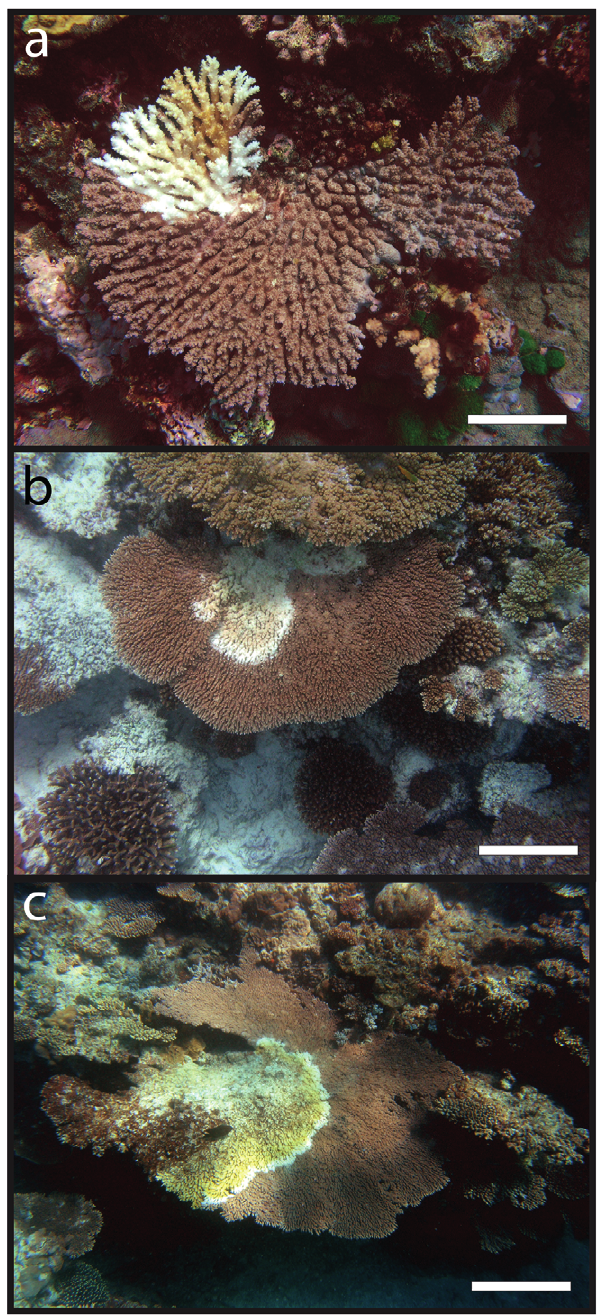
Figure 2. Acroporid White Syndrome in Tabular Acropora spp. a) size class I [0–80 cm] (Scale=5 cm) b) class II [80–160 cm] (Sca- le=25 cm), c) class III [ . 160 cm] (Scale=50 cm). doi:10.1371/journal.pone.0026829.g002 (Figure 3a). Acroporidae was observed to be the dominant family of coral, accounting for 84.2 6 2.9% of all coral cover. Tabular morphology was the dominant growth form of Acropora observed during surveys (averaging 66.3 6 6.6% of all Acropora corals), varying between 3.7% (4 th Point) to 25.1% coverage (2 nd Point). A weak but significant relationship was observed in that white syndrome was more common in sites with a higher cover of tabular Acropora ( b = 2 0.44, r 2 =0.2, p , 0.05). This relationship was not observed